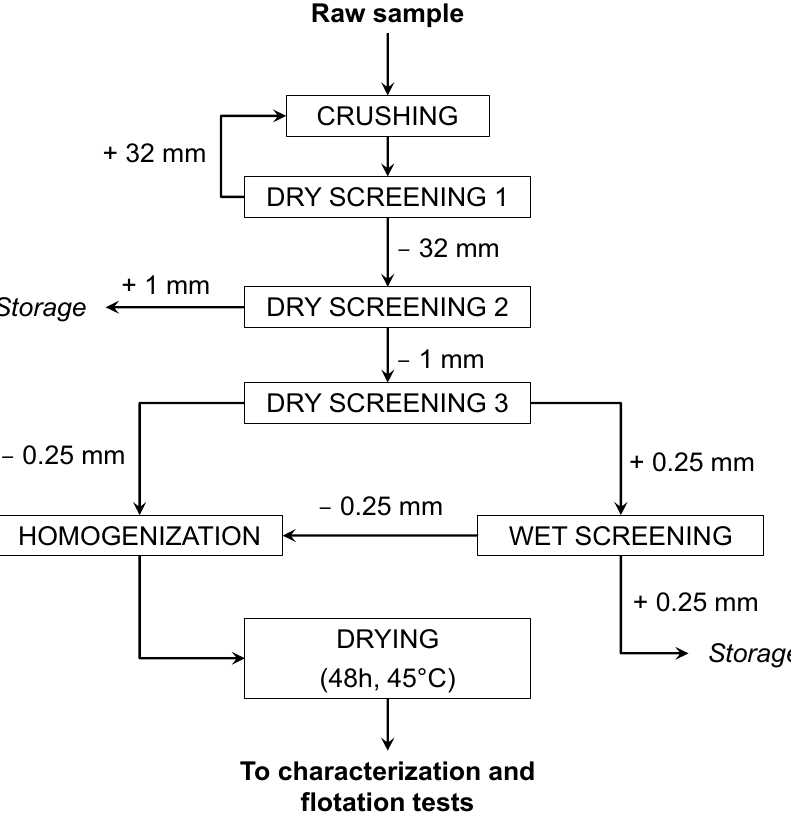
Figure 3. Preparation of samples for testing.